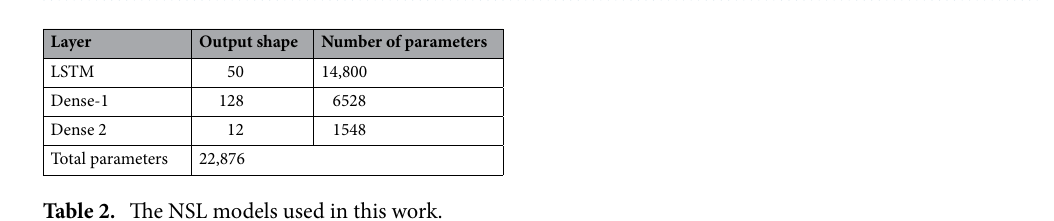
Table 2. The NSL models used in this